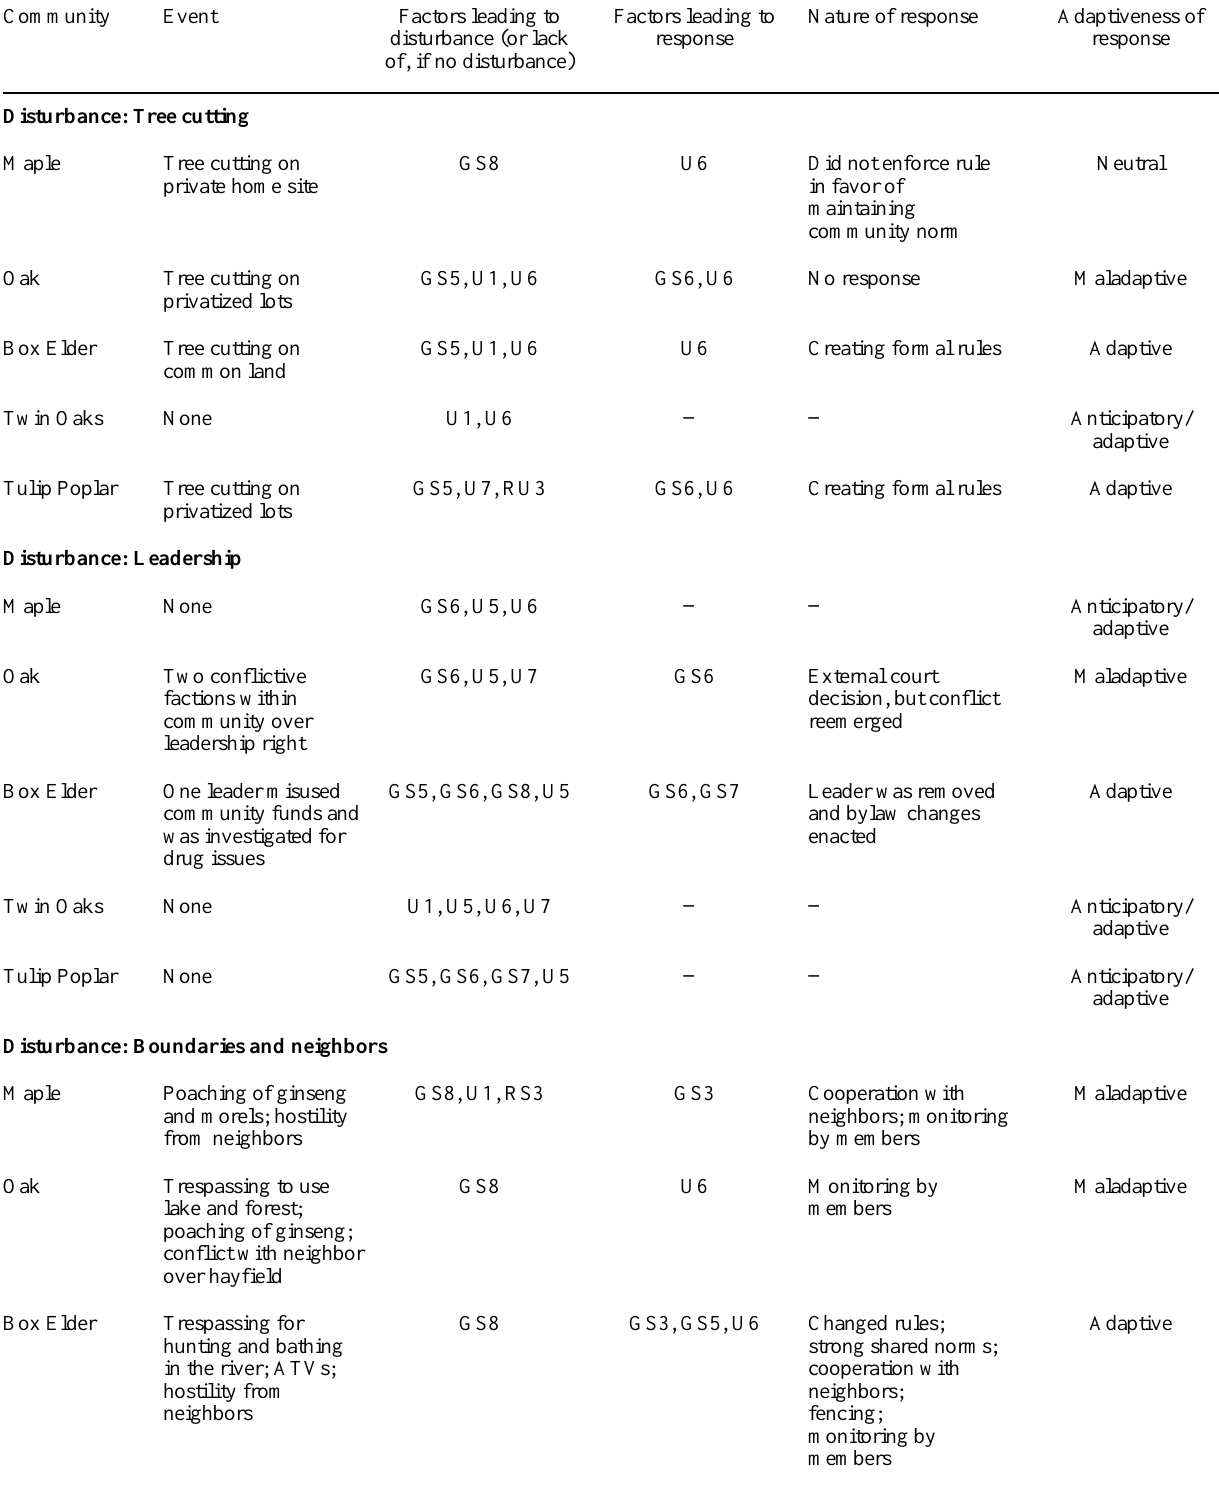
Table 3 . Factors leading to disturbances and responses in the five communities.